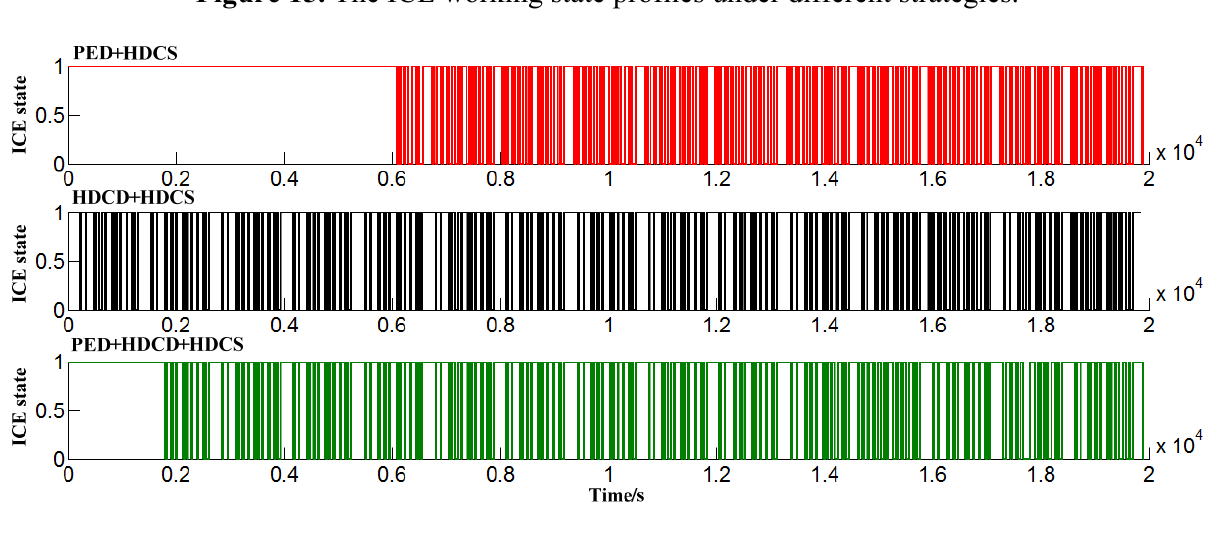
Figure 16. The ICE torque profiles under different